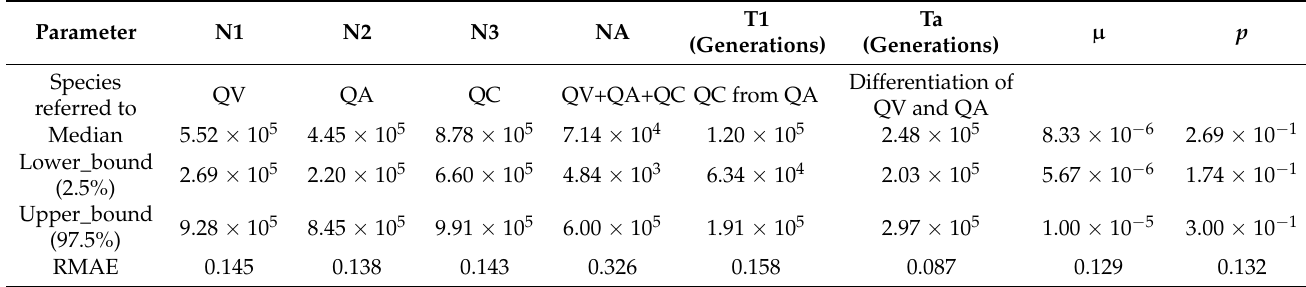
N1, effective population size of Q. variabilis ; N2, effective population size of Q. acutissima ; N3, effective population size of Q. chenii ; NA, effective population size of ancestral population; t1, time since divergence between Q. acutissima and Q. chenii ; ta, time since divergence between Q. acutissima and Q. variabilis